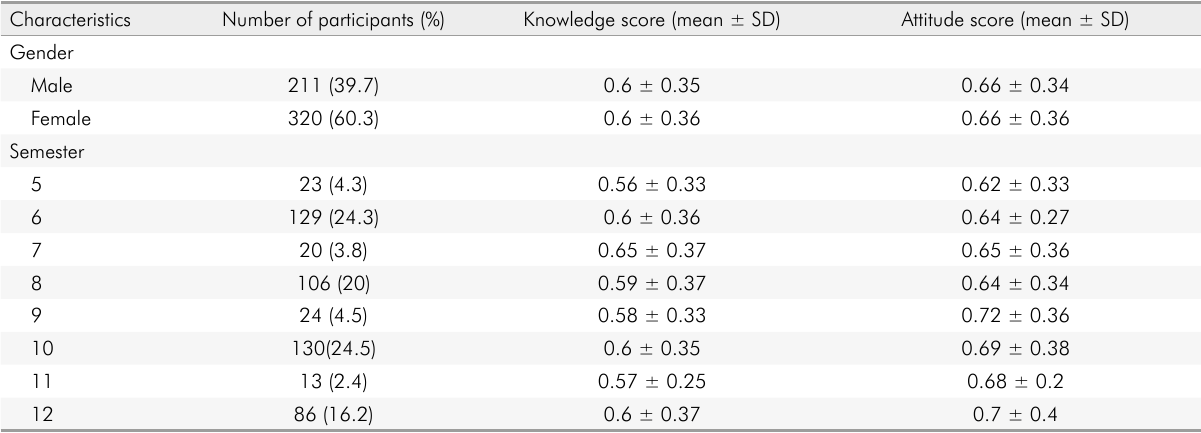
Table 2. Demographic characteristics of